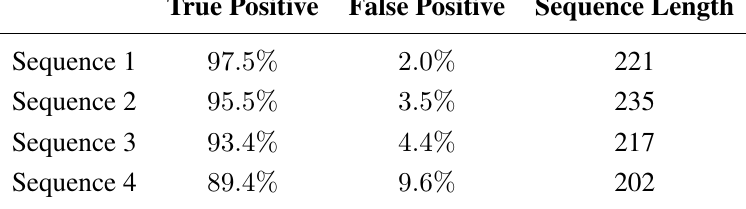
Table 1. Quantitative analysis in 4 sequences acquired by our